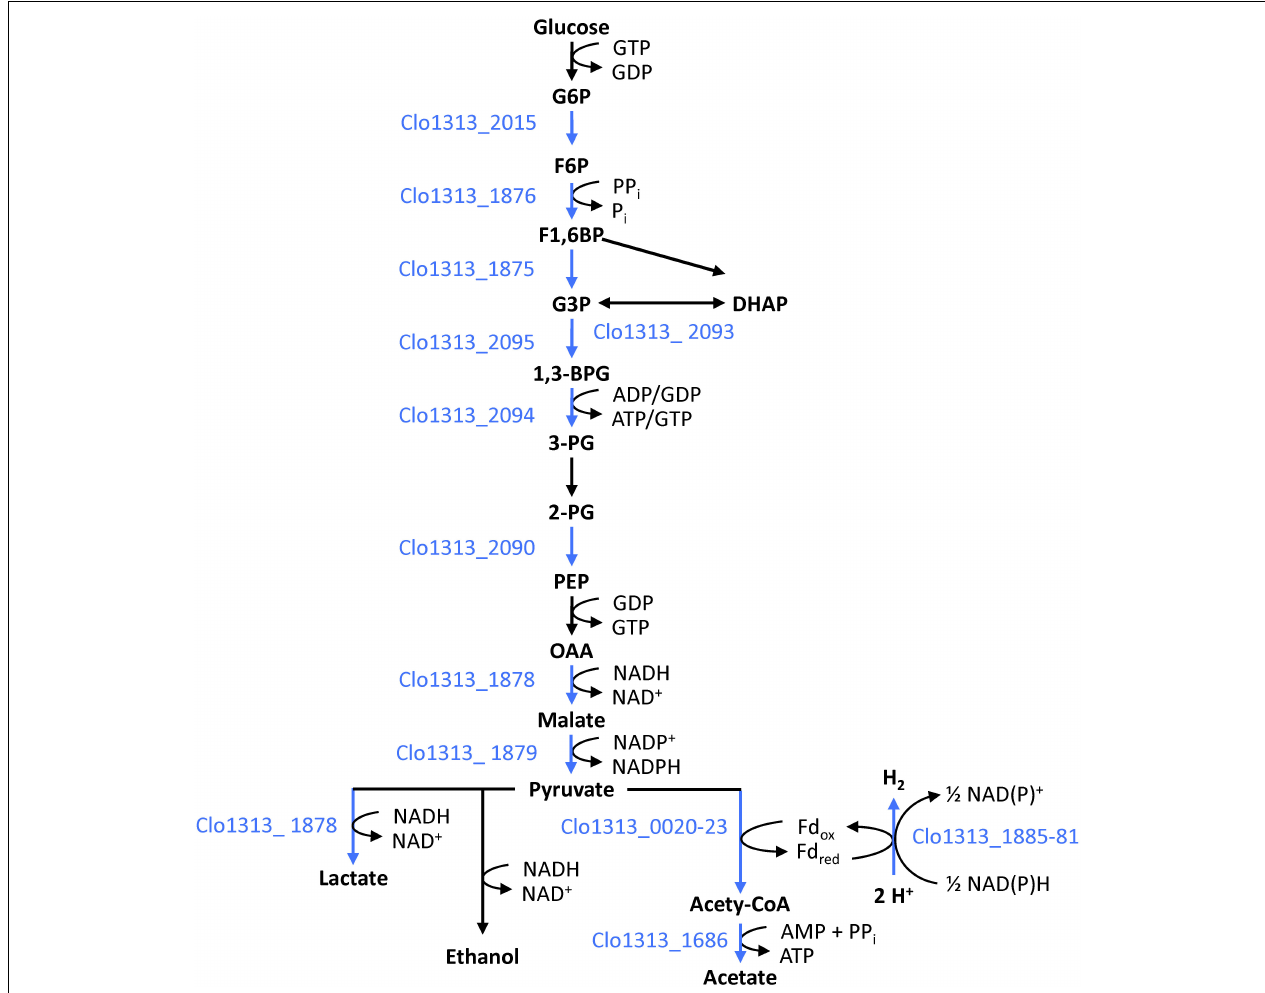
FIGURE 5 | Role of Rex_2471 in regulating glycolysis. The Rex_2471 binding site appears upstream of genes encoding enzymes that account for most steps in glycolysis. Locus tags encoding enzymes downstream of Rex binding sites are shown to the left or below arrows depicting the step they putatively catalyze. Blue text and blue arrows indicate steps putatively regulated by Rex_2471. See also Table 4 for more details. Cofactors to the right of arrows indicate the general specificity observed in Zhou et al. (2013).